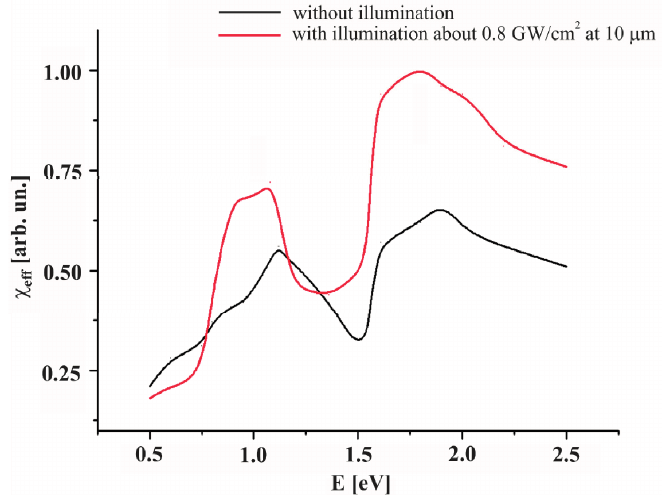
Figure 3. The calculated dispersion of the second order susceptibility with and without the laser